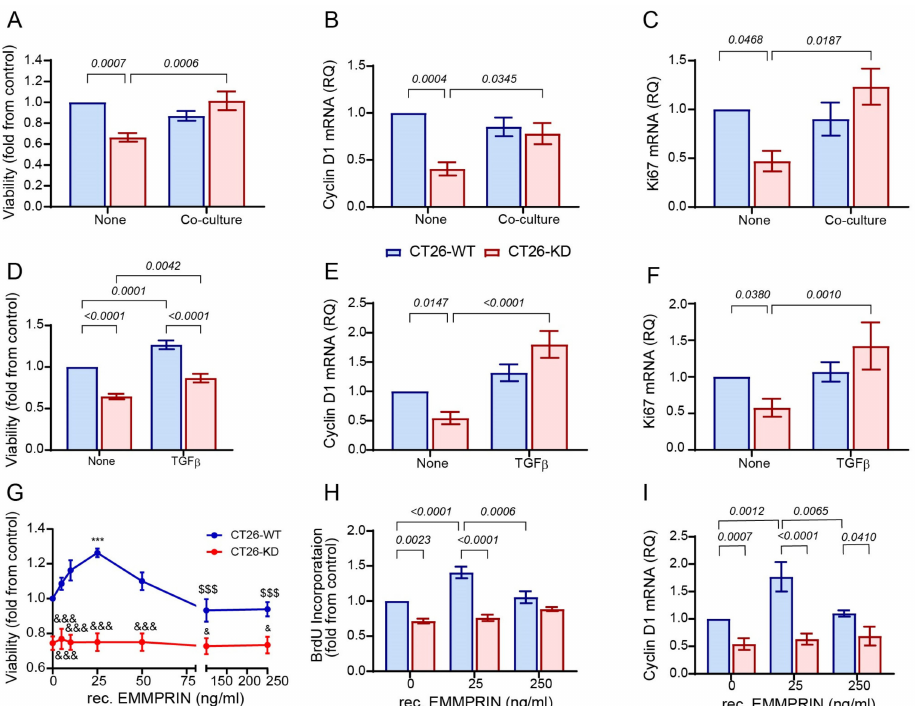
Figure 5. CT26-KD exhibits reduced proliferation. CT26-WT or CT26-KD cells (8 × 10 4 cells) were incubated under the same conditions as described in Figure 4. Cell proliferation was measured using ( A , D , G ) the CCK8 kit ( n = 8) or ( H ) the BrdU kit ( n = 7) as well as the expression of ( B , E , I ) the cyclin D1 mRNA ( n = 5) or ( C , F ), and the Ki67 mRNA ( n = 4). ( A – C ) Cells incubated in co-cultures, ( D , F ) single cultures incubated with the addition of TGF β (10 ng/mL), and ( G – I ) cells incubated with the addition of recombinant EMMPRIN (25 and 250 ng/mL). Data are presented as means ± SE, and analyzed using a two-way ANOVA followed by Bonferroni’s post-hoc test. ***, p < 0.001 relative to the CT26-WT without addition of rec. EMMPRIN; $$$, p < 0.001 relative to CT26-WT with 25